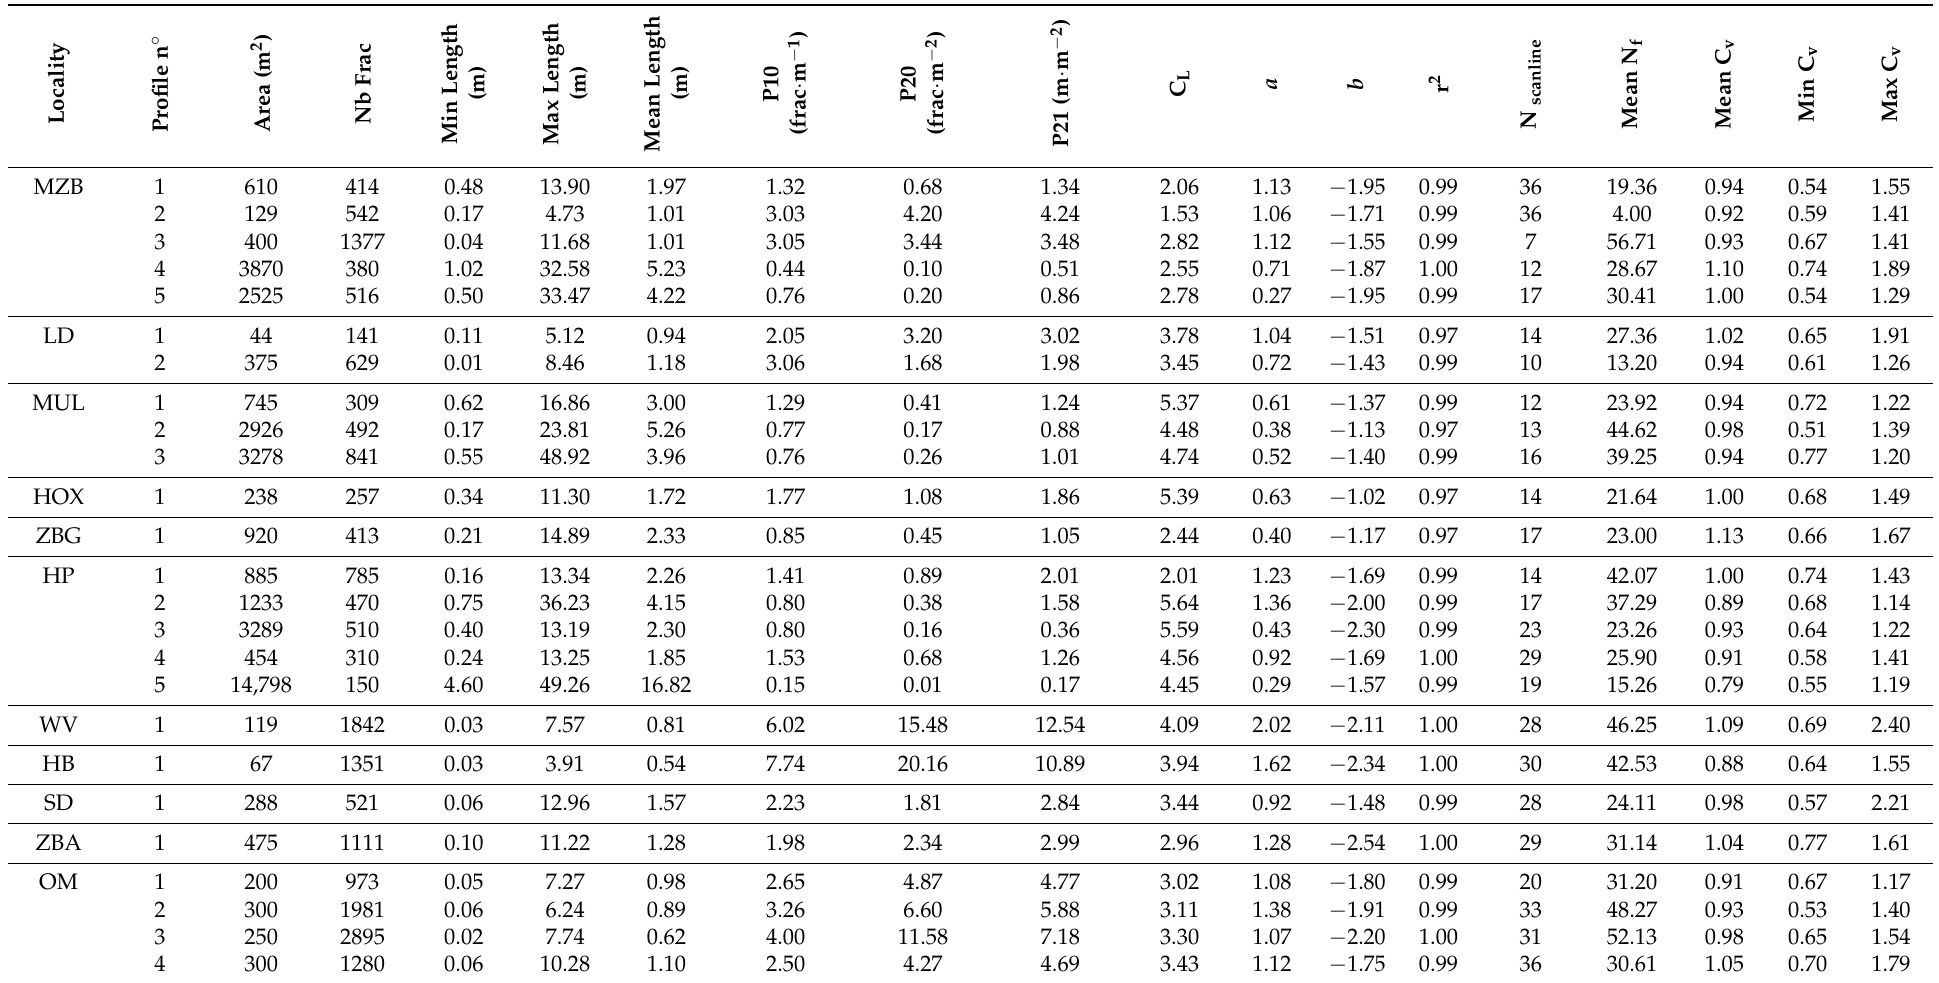
Table 3. GIS Fracture network statistics, with dimension features, connectivity (C L ), power-law parameters a, b, and r 2 , number of artificial scanlines (N scanline ), number of nodes per scanline (N f ), and spacing (C v